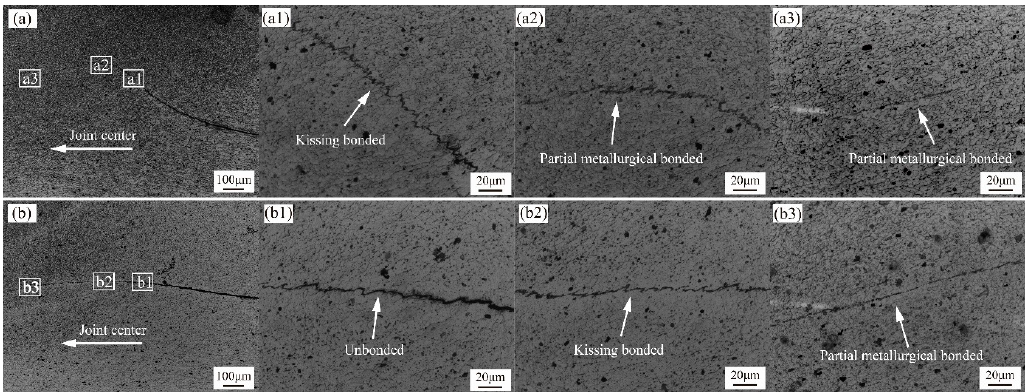
Figure 12. Optical micrographs of metallurgical bonding in the joints welded with the ( a ) concave tool and ( b ) involute tool. ( a1 – a3 ) were amplification of the interfacial metallurgical bond in Figure 12a. ( b1 – b3 ) were amplification of the interfacial metallurgical bond in Figure 12b.